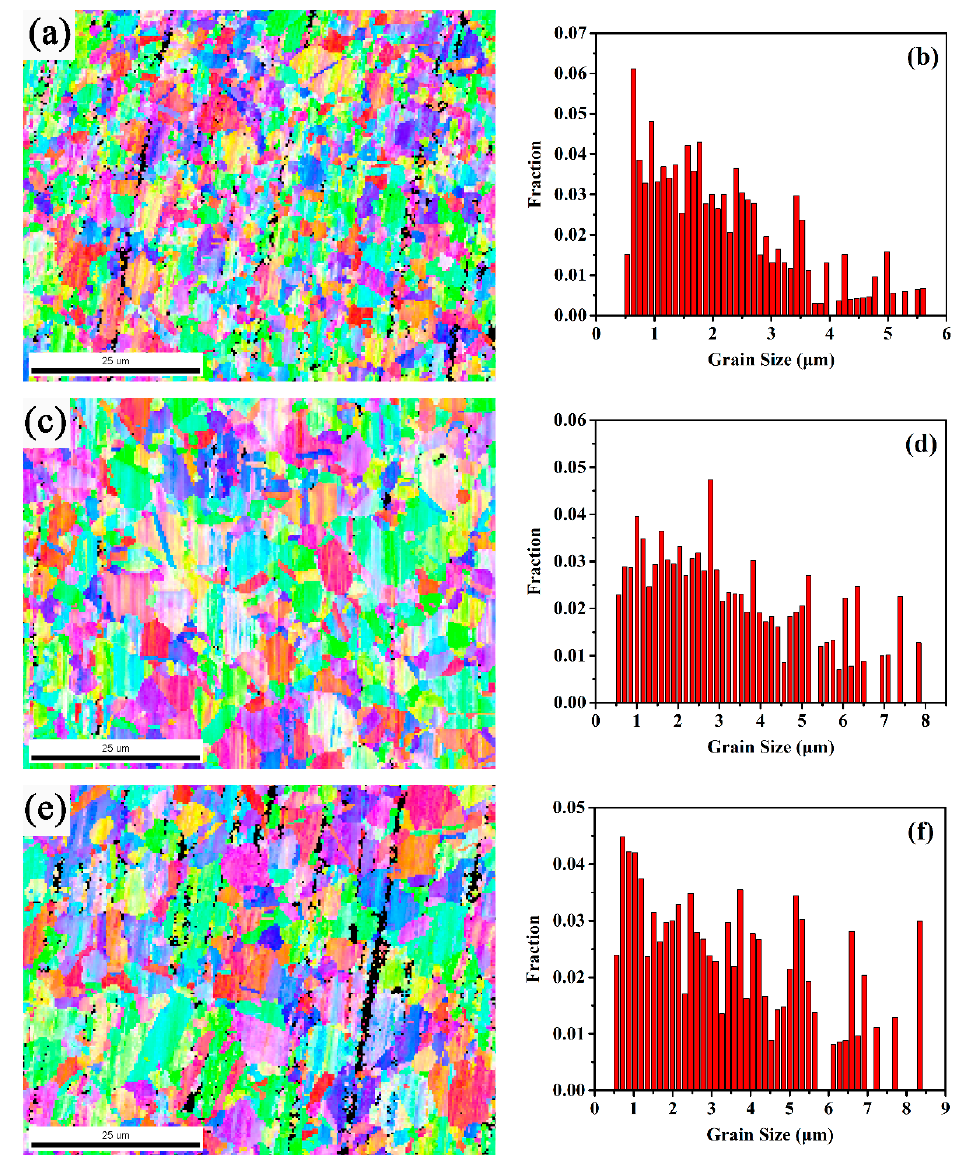
Figure 8. Orientation image microscopy (OIM) maps and grain size distribution of the specimens to failure with strain rate of 1 × 10 − 3 s − 1 at different temperature, respectively: ( a , b ) 1060 °C, ( c , d ) 1080 °C failure with strain rate of 1 × 10 − 3 s − 1 at di ff erent temperature, respectively: ( a , b ) 1060 ◦ C, ( c , d ) 1080 ◦ C and ( e , f ) 1100 °C. and ( e , f ) 1100 ◦